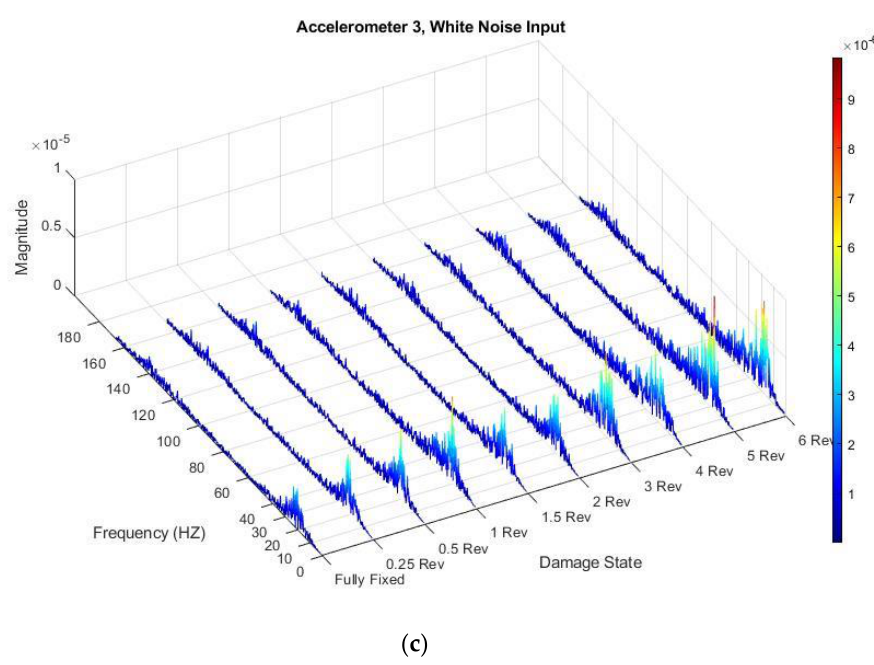
Figure 10. FRF of Arduino measurement for each bolt-loosening scenario (Damage State) with a white noise input for ( a ) Accelerometer 1; ( b ) Accelerometer 2 and ( c ) Accelerometer 3.